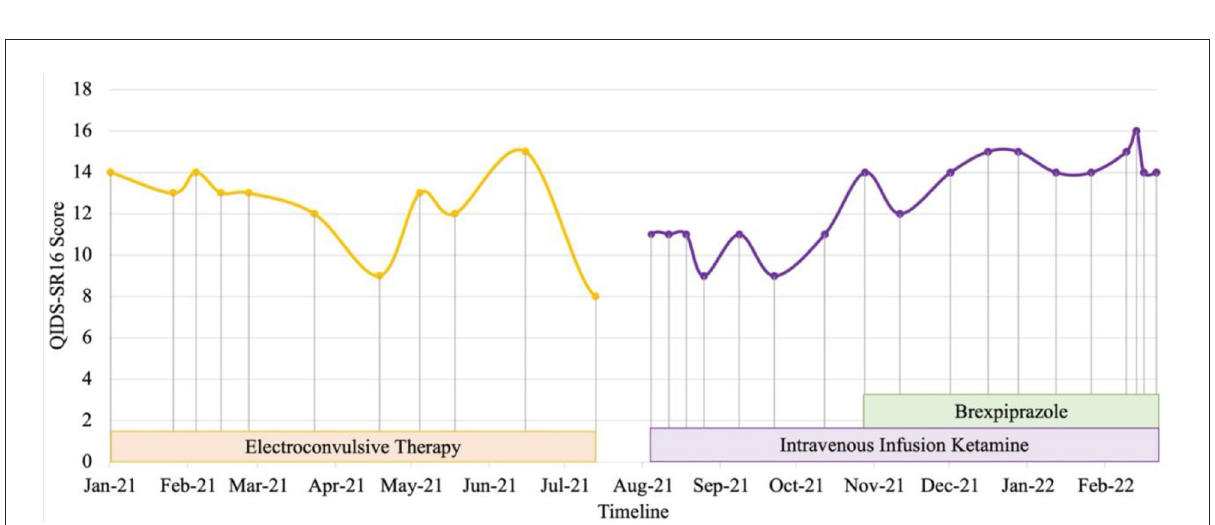
FIGURE2 Case 2 timeline for longitudinal course of treatment response. Patient 2 is a male in his 20’s with a current diagnosis of treatment-resistant bipolar type II depression. Brexpiprazole was initiated at the dose of 0.5mg and titrated to a maximum of 3mg in combination with intravenous infusion ketamine 0.5 mg/kg. Co-medications include lamotrigine 300mg, quetiapine 800mg, vortioxetine 20mg and clonazepam 0.5mg with cognitive behavioral therapy and family perticipation in online family support group. Currently, despite fluctuations in mood, he expressed improved levels of satisfaction and self-efficacy in terms of occupational